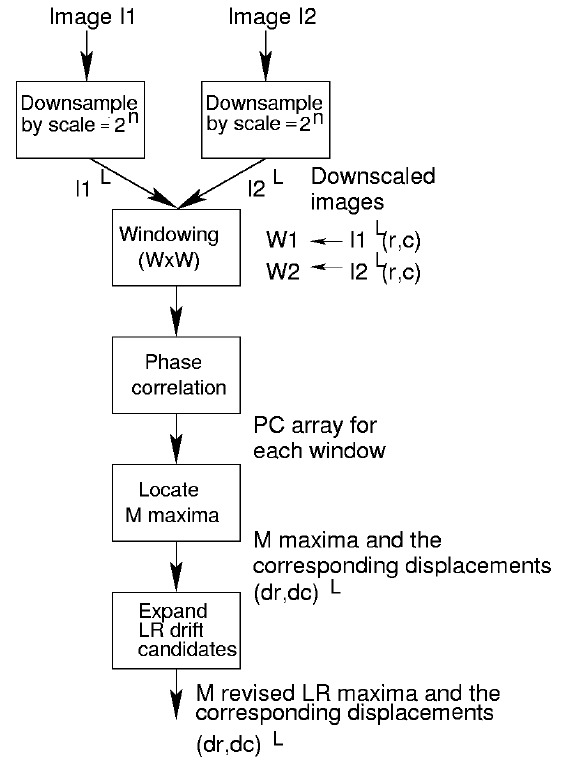
Fig. 1. The low-resolution part of the algorithm. The processing after down-sampling is shown only for one window pair in the dia- gram. In the algorithm, this is performed for each window pair with a grid step of (W/2,W/2) low-resolution